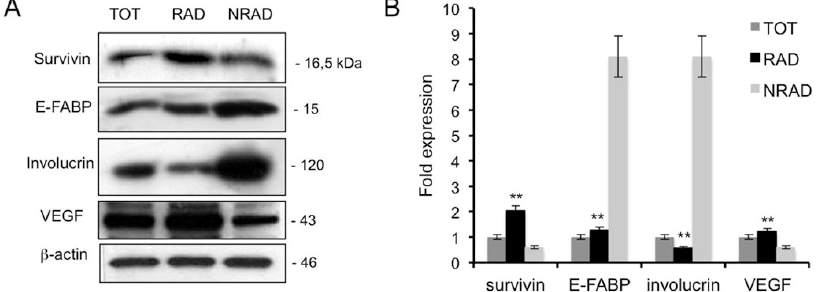
Figure 3. Expression of stem cell and differentiation markers in RAD, NRAD and TOT cells from cSCC. ( A ) Cells were analyzed immediately after separation, and levels of markers were determined by Western blot analysis. β -actin was used as loading control; ( B ) Bar graphs show the average densitometry values normalized to actin. * p < 0.05; ** p < 0.01.